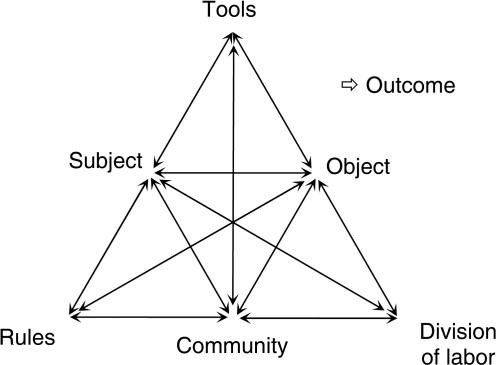
The Structure of Human Activity after Engeström [10].